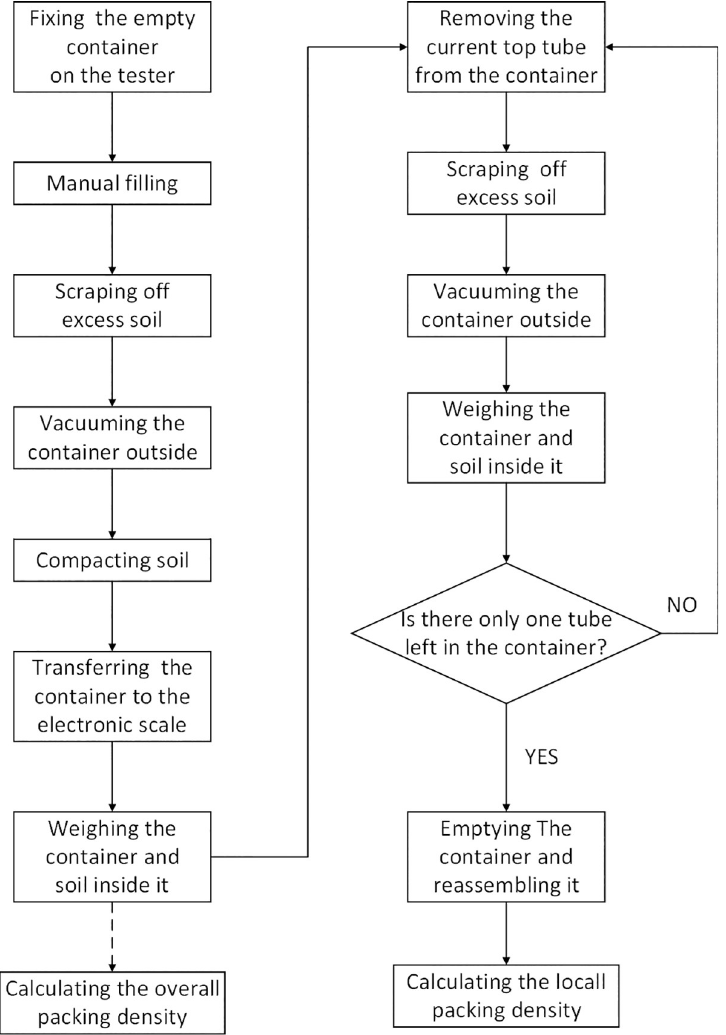
Fig 3. The flow chart of experimental operations. Manual filling means the container is overfilled slightly with soil using a plastic measuring cup, during which the cup need shaking to obtain a steady soil flow. Scraping off excess soil means carefully scraping soil beyond the rim of the top tube with a straight-edged thin plate to make soil volume consistent with the consistent the container capacity. Actually, a stainless-steel ruler was used. The dashed arrow indicates that the overall packing density could be calculated without further operations. The operation of remove- scrape-weigh refers to the operations forming a close loop.